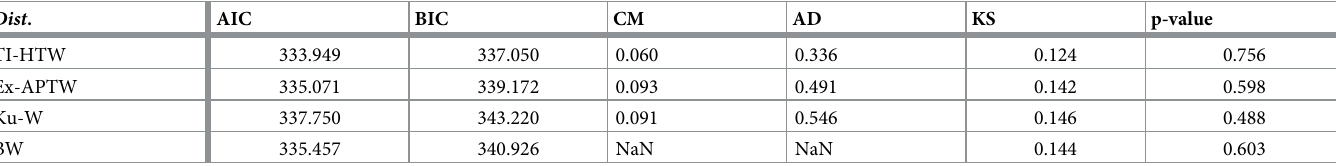
Table 10. Analytical measures of of the TI-HTW and competitive models for data 2. Dist